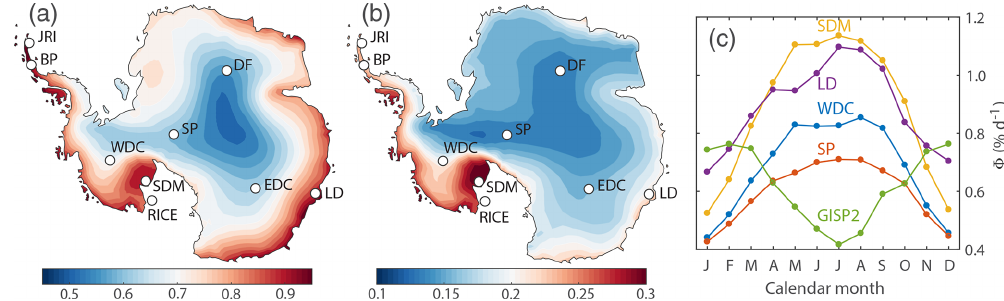
Figure 2. Calibrating Kr-86 excess. (a) Annual mean (cid:56) in Antarctica over 1979–2017 in units of percent per day (%d − 1 ). (b) Interannual variability (1 σ standard deviation) of annual mean (cid:56) over 1979–2017 in units of percent per day (%d − 1 ). (c) Annual cycle in (cid:56) for 1979– 2017 for the indicated site. Table 1. Ice core sites used in this study, with N the number of samples included in the calibration study. See the main text for acronyms. Site T A (cid:56) Latitude